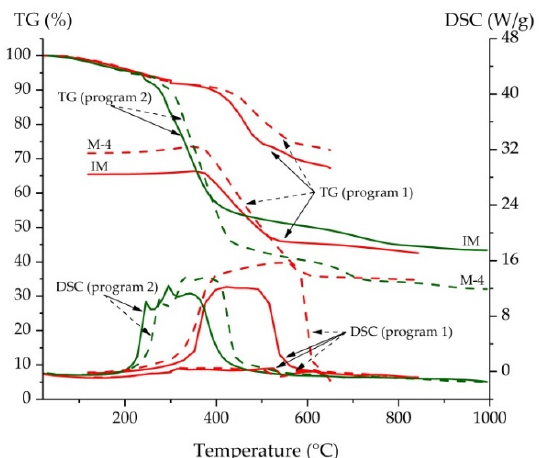
Figure A1. TG and DSC curves for kerogen samples. Green curves are for oxidizing atmosphere (Program 2); red curves for inert gas measurement followed by oxidizing atmosphere and for inert gas measurement (Program 1): IM—solid line, M-4—dashed.